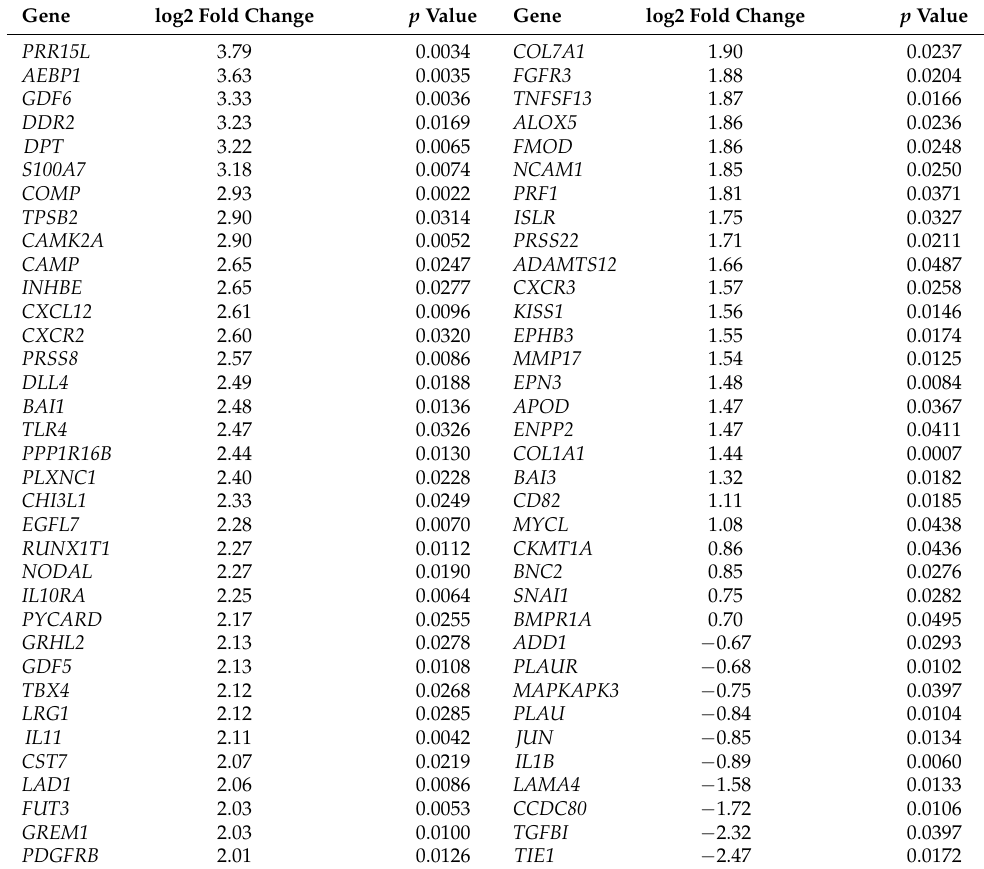
Table 3. Genes deregulated in EV PIC-treated versus untreated